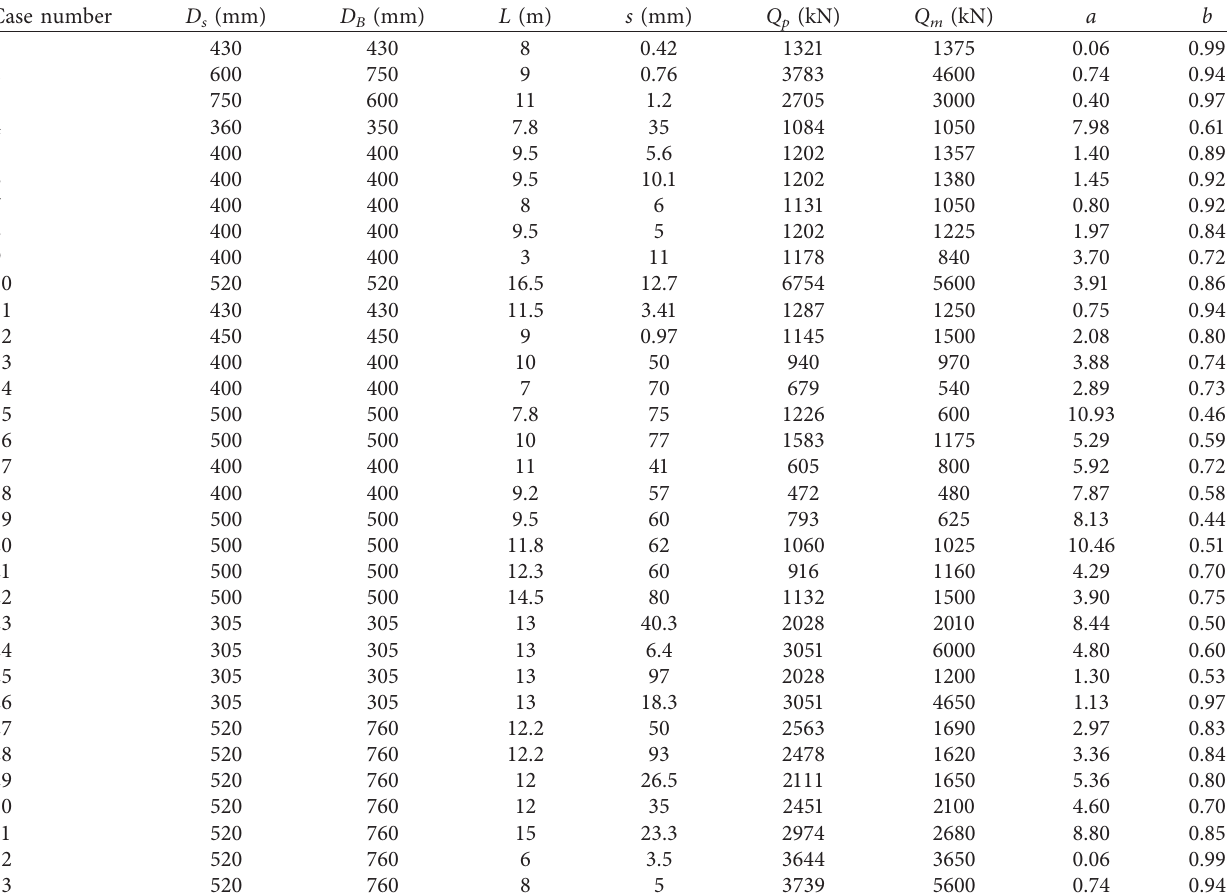
Table 1: Load testing data of pile capacity in noncohesive